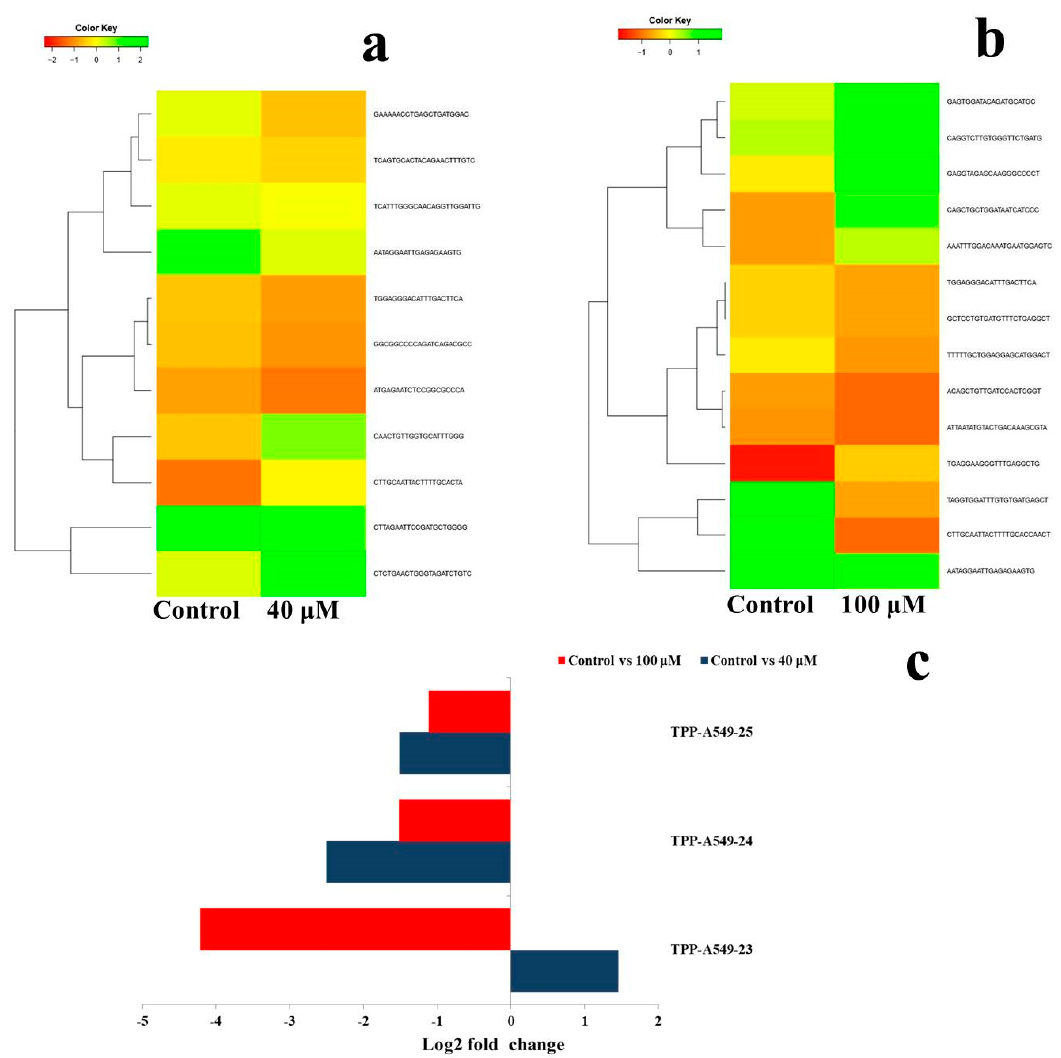
Figure 9. The differential expression pattern of putative novel microRNAs. ( a ) Untreated control vs. 40 μ M EGCG treatment; ( b ) Untreated control vs. 100 μ M EGCG treatments; ( c ) Log2 fold change of three putative novel microRNAs which were common in untreated control vs. 40 and untreated control vs. 100 μ M EGCG treatment. Color key- red: up-regulation, green: down-regulation and yellow: neutral expression.